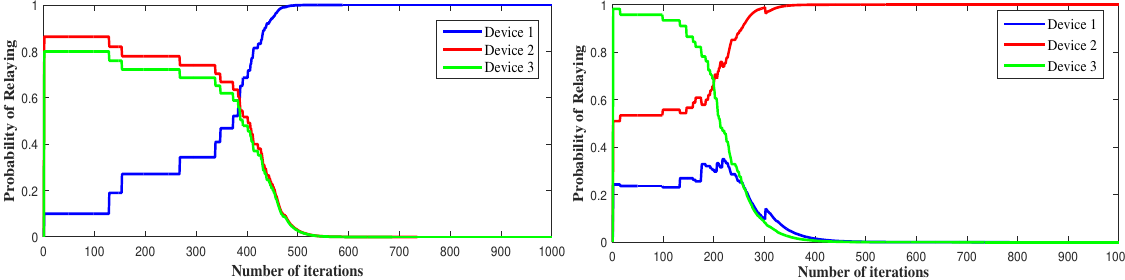
Figure 3. Convergence to pure Nash equilibrium using the linear reward-inaction